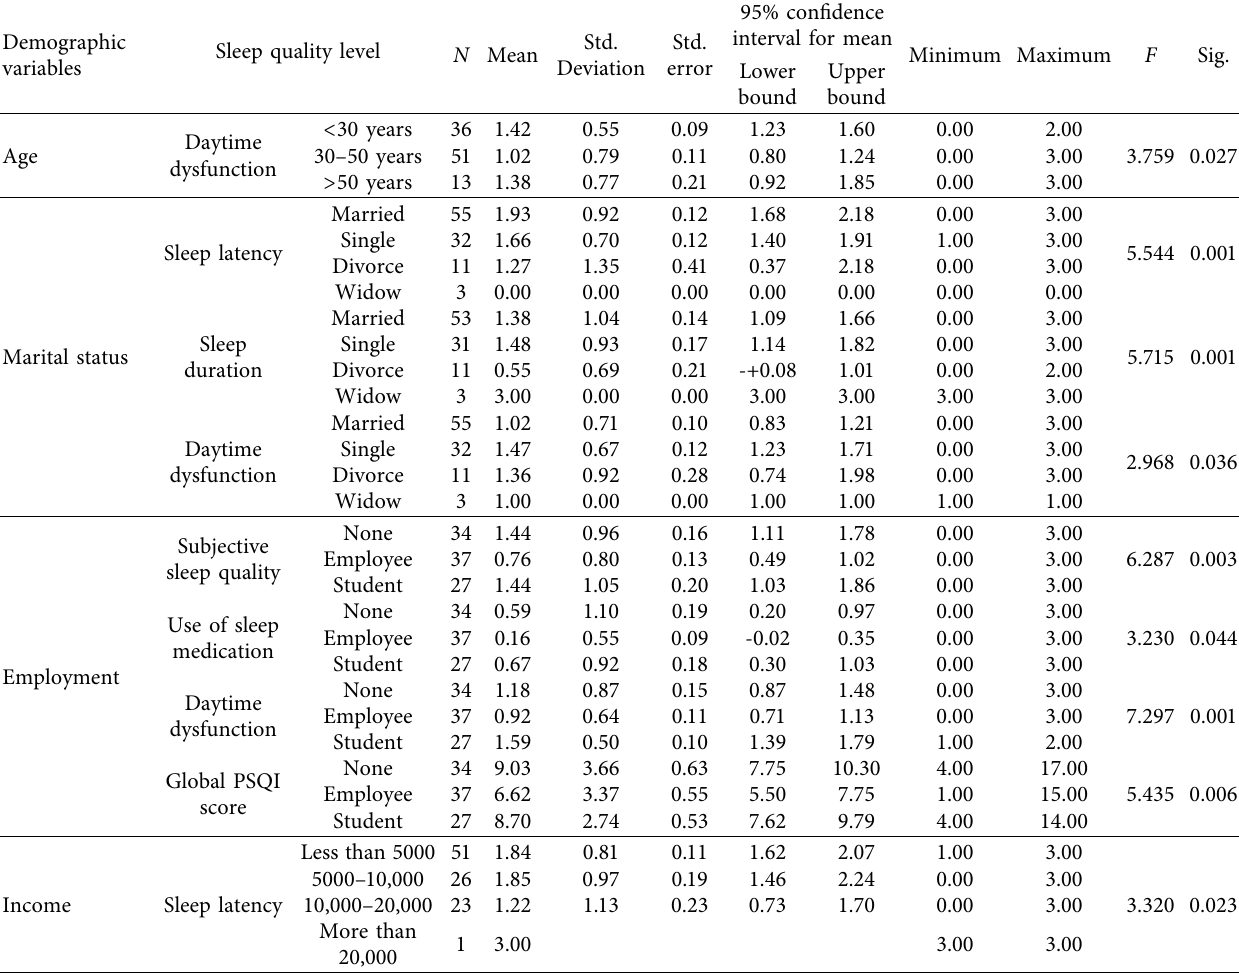
Table 2: Statistical difference among study participants’ demographic variables in sleep quality